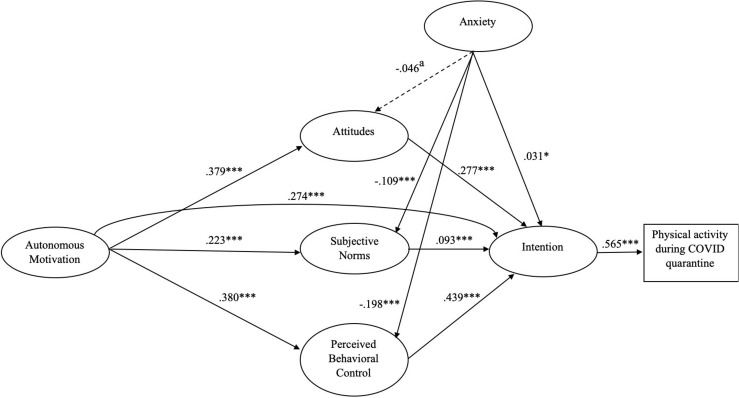
The total sample model. Results of the structural equation model for the proposed integrated theoretical model related to the total sample. Dashed lines indicate paths that were not statistically significant (p > 0.05). ∗∗∗p < 0.001; ∗p < 0.05; a p = 0.05.